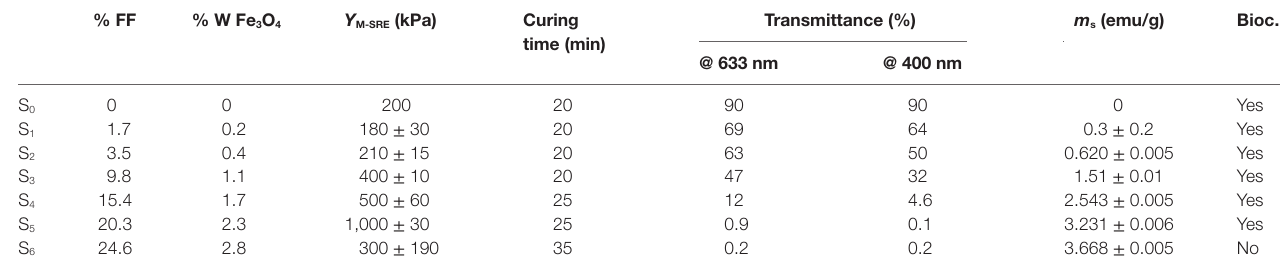
TaBle 3 | summary of the parameters obtained in the characterization of